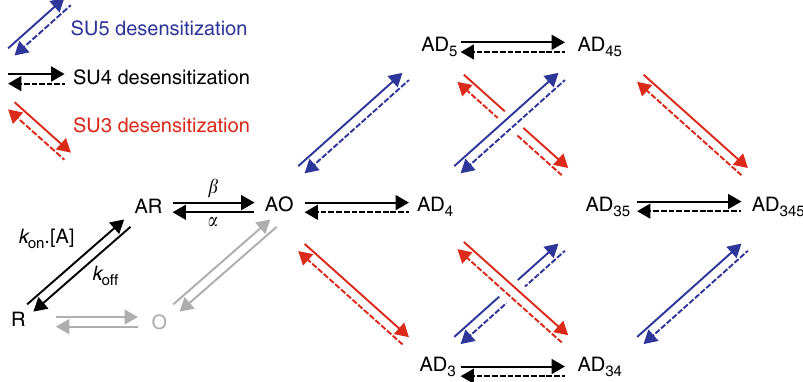
Fig. 3 General scheme for the simulation of desensitization: an asymmetric non-concerted model. The fi rst part in the kinetic scheme is the binding of the agonist A to the resting state R, which favors the opening of the channel (AO state) with a gating ef fi cacy E = β / α . Of note, unliganded openings do exist but are not taken into account for our kinetic modeling as they barely contribute to the electrophysiological response (see main text). We also only include one binding event, even though α 1 β 2 γ 2 GABA A Rs contain two binding sites whose occupation is required for substantial activation. Upon channel opening, the receptor can then transit from a fully activated AO state to states where only one subunit enters its desensitized conformation (AD 3 , AD 4 , and AD 5 ). From these states, a second subunit can also desensitize, before the fi nal step leading to the state in which all subunits are